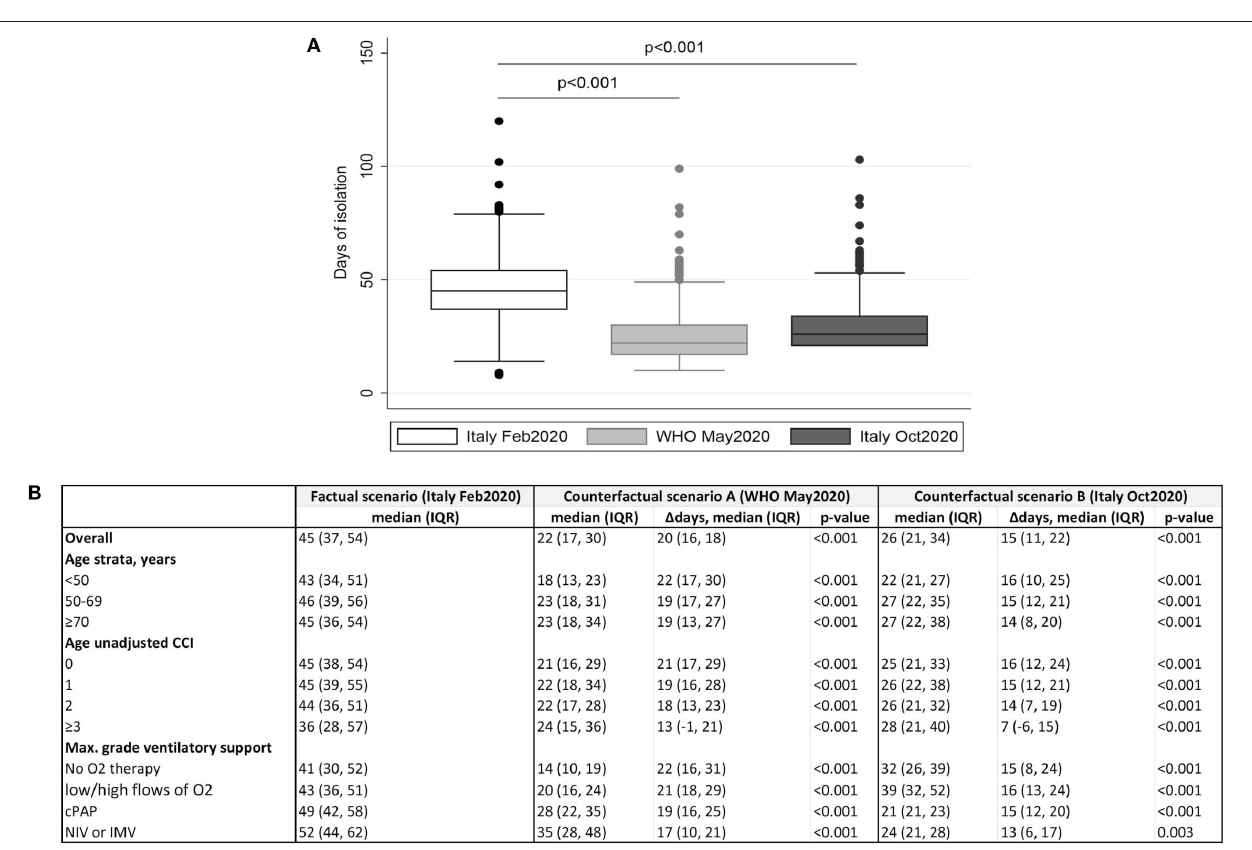
FIGURE 1 | Comparison of time from symptoms onset to release from isolation by application of February-Italian, May-WHO, and October-Italian criteria. (A) Box plot representing median days spent in isolation by application of Italian and WHO criteria for releasing COVID-19 patients from isolation . P -values by Wilcoxon signed rank test for paired data. (B) Mean ( ± standard deviation) of the isolation time under the three scenarios (February-Italian, May-WHO, and October-Italian guidelines) according to age, CCI, and maximum grade of respiratory support. Average treatment effects (95%CI) for WHO May 2020 and Italian October 2020 criteria, using the factual scenario (Italian February 2020) as the comparator, were